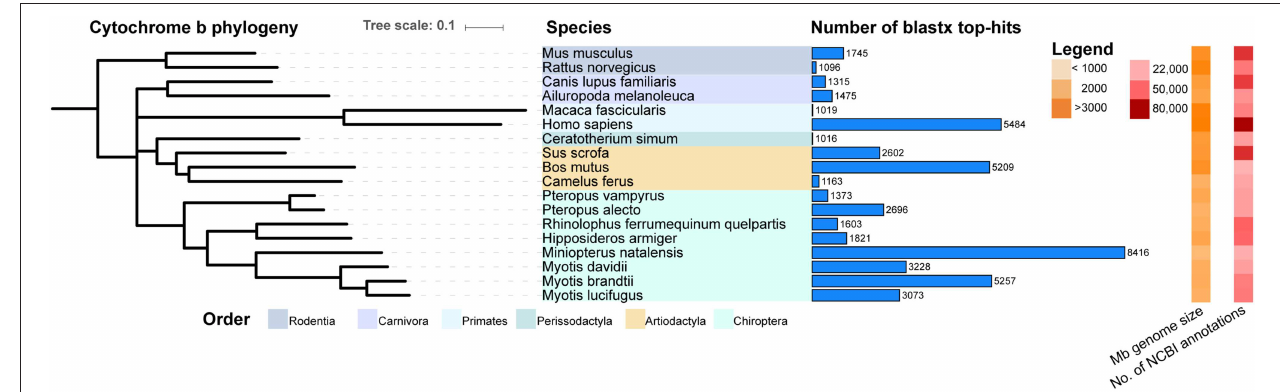
FIGURE 1 | Mops condylurus transcriptome top-hits to Mammalia in NCBI database. MrBayes phylogenetic tree for the cytochrome B gene was built with Geneious (v10.0.5) on ClustalW aligned genes. Contigs generated via de novo assembly of M. condylurus sequences were subjected to blast2go analysis against the GenBank Mammalia database. For each contig a top-hit (blastx match with the lowest e-value) was determined and the number of contigs, for species with more than 1000 top-hits, is represented with horizontal light-blue bars. The order classification for each species is indicated by colored panels. The genome size in megabases and number of annotated mRNAs present in GenBank, at the time of analysis, are displayed as orange and red heat maps, respectively. This figure was generated with interactive tree of life